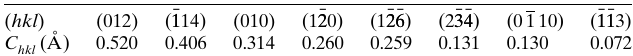
Table 12 Magnitudes of C hkl in corundum [space group type R (cid:4) 33 c , the structure is reported by Lewis et al.